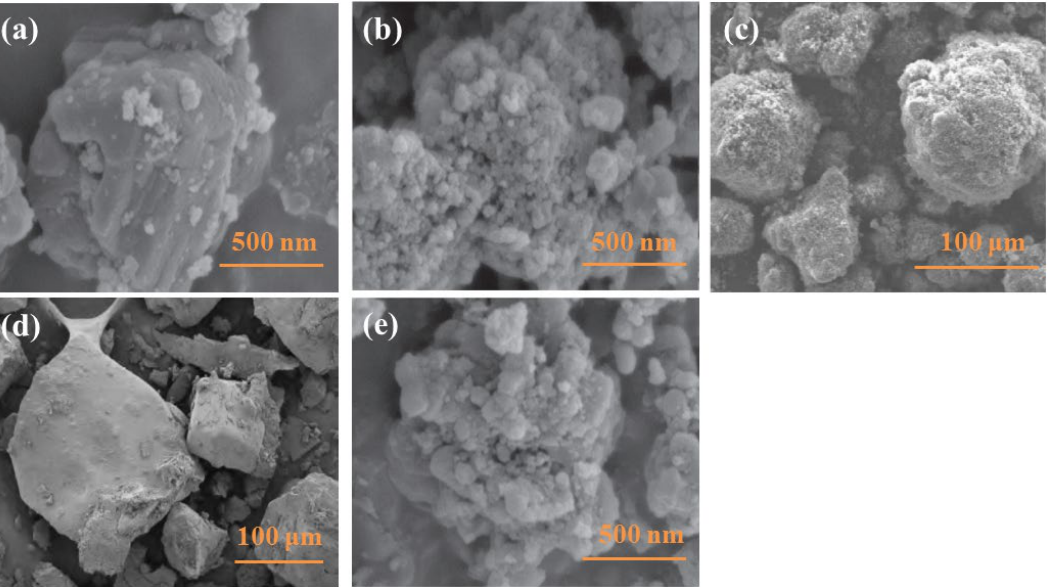
Figure 4. SEM images of ( a ) raw boron [71]; ( b ) B@AP - 10% [71]; ( c ) B@AP - 50% [72]; ( d ) B@AP/LiP - 36%/44% [73]; and ( e ) B@NQ - 10% [71].